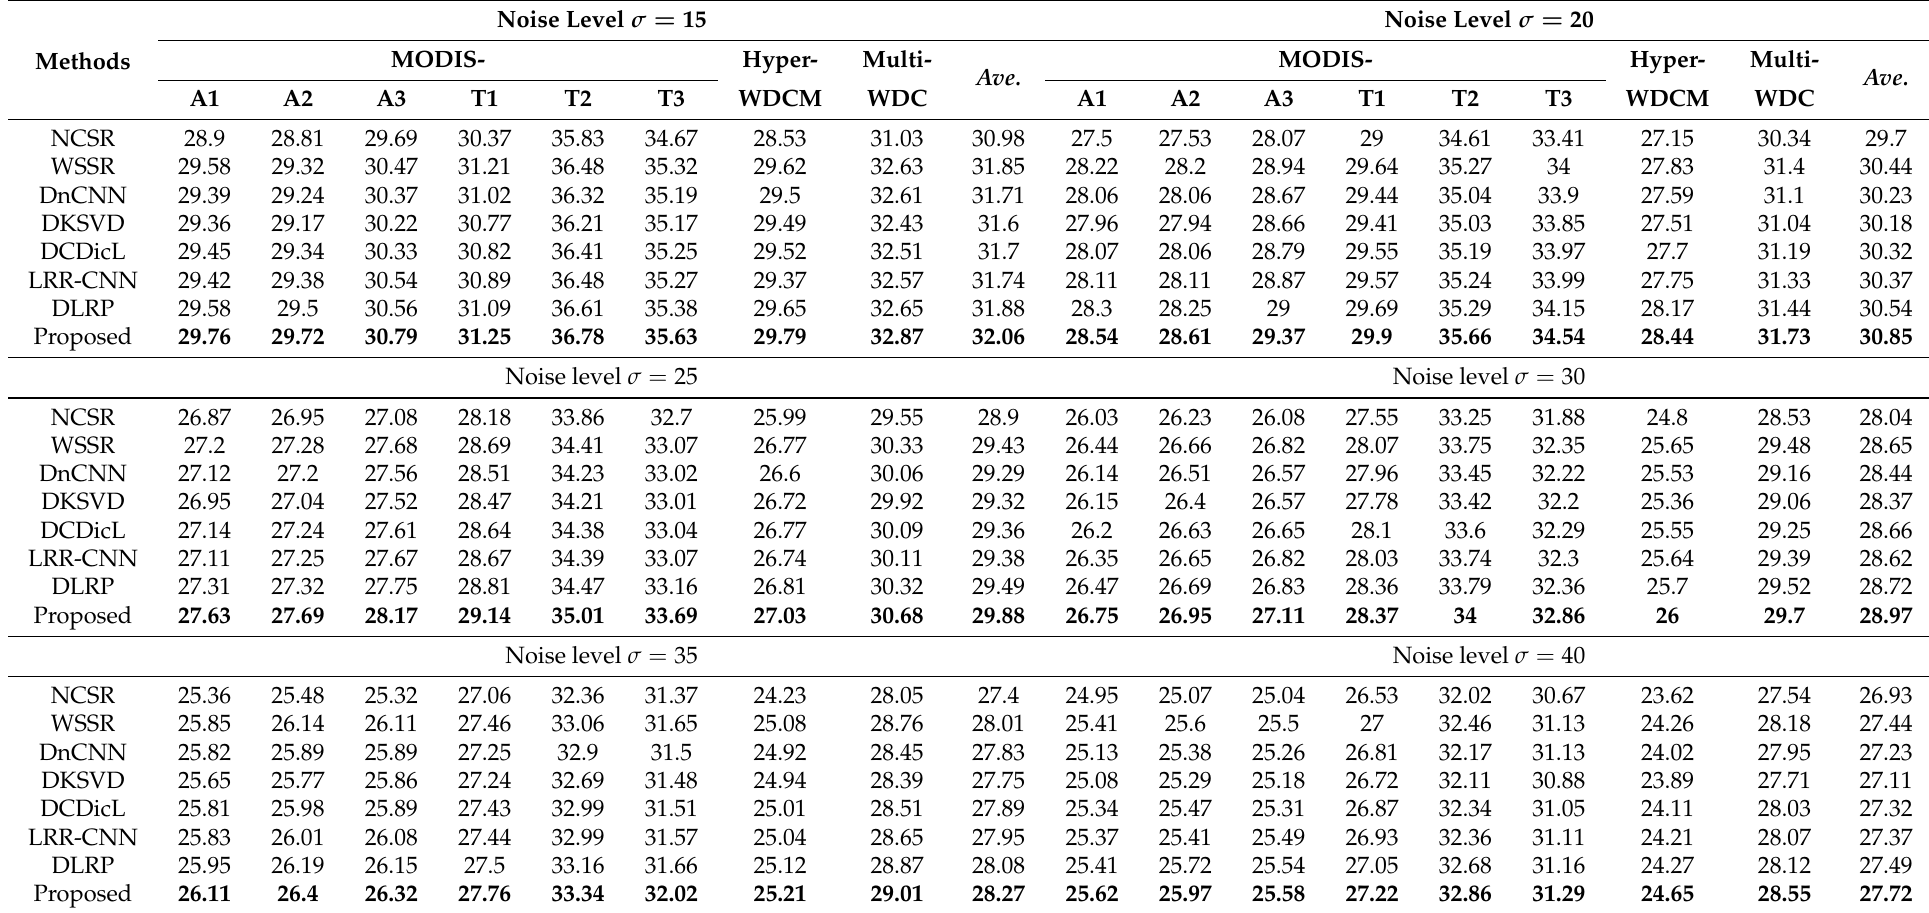
Table 1. PSNR (dB) comparisons of the state-of-the-art. For each image at each level, the best result is marked with bold